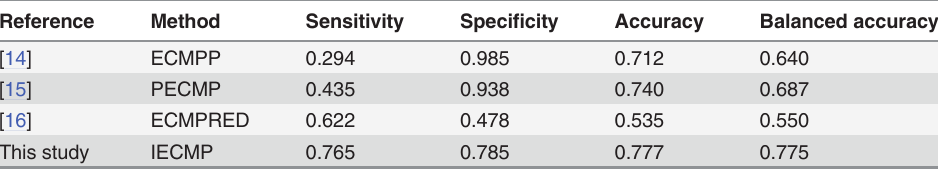
Table 7. The prediction results compared with other methods on the independent testing